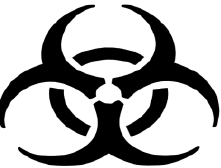
Figure 5. International infectious substance symbol as adapted. [18].